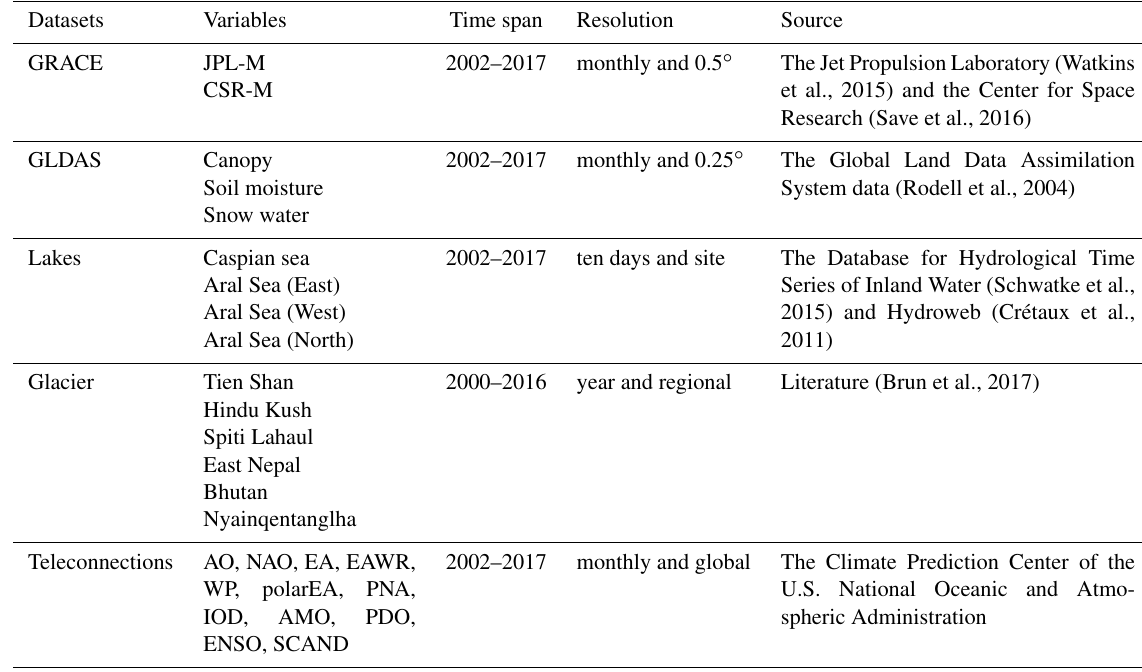
Table 1. Descriptions of datasets used in this study.